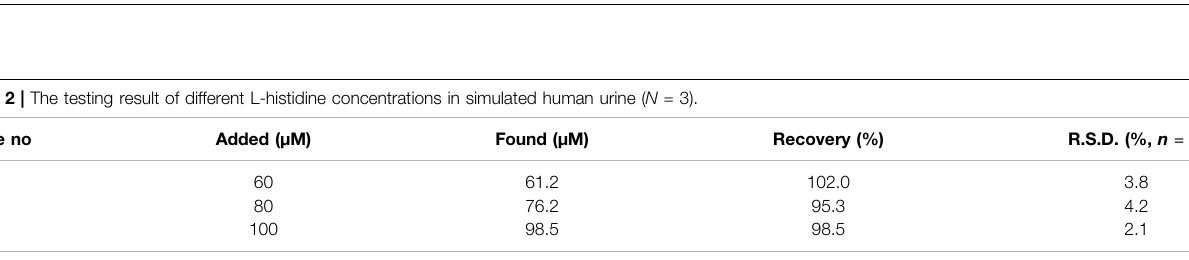
FIGURE 4 | Selectivity and simulated samples detection. (A) Absorption spectra of the sensing system in the presence of different molecules, including L-His, L-alanine (L-Ala), L-proline (L-Pro), L-phenylalanine (L-Phe), glucose, NaCl, and urea (the concentrations of the molecules were all 80 μ M). (B) The rate of absorbance changing (A 0 -A/A 0 ) at 655 nm change with different molecules.